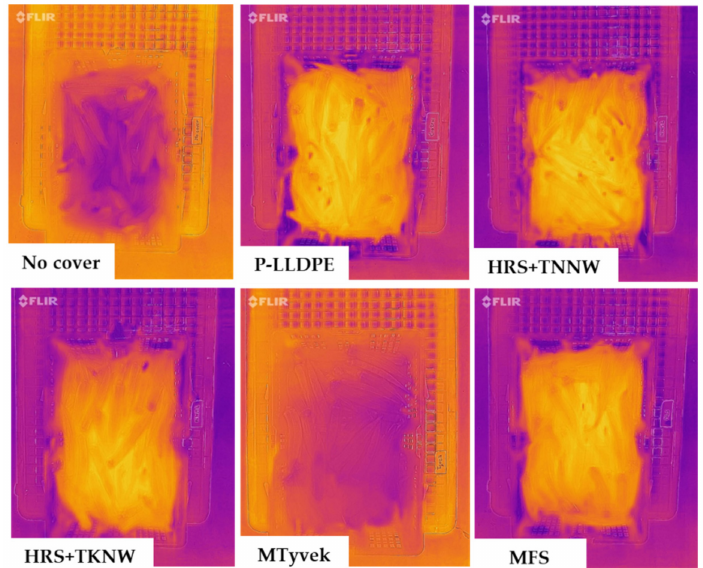
Figure 7. Thermal imaging among the six treatments represented pulp temperature after finishing simulated transportation at 30 ◦ C for 15 h (removal covering). Purple and orange color zones represent cool and warm temperature gradients,